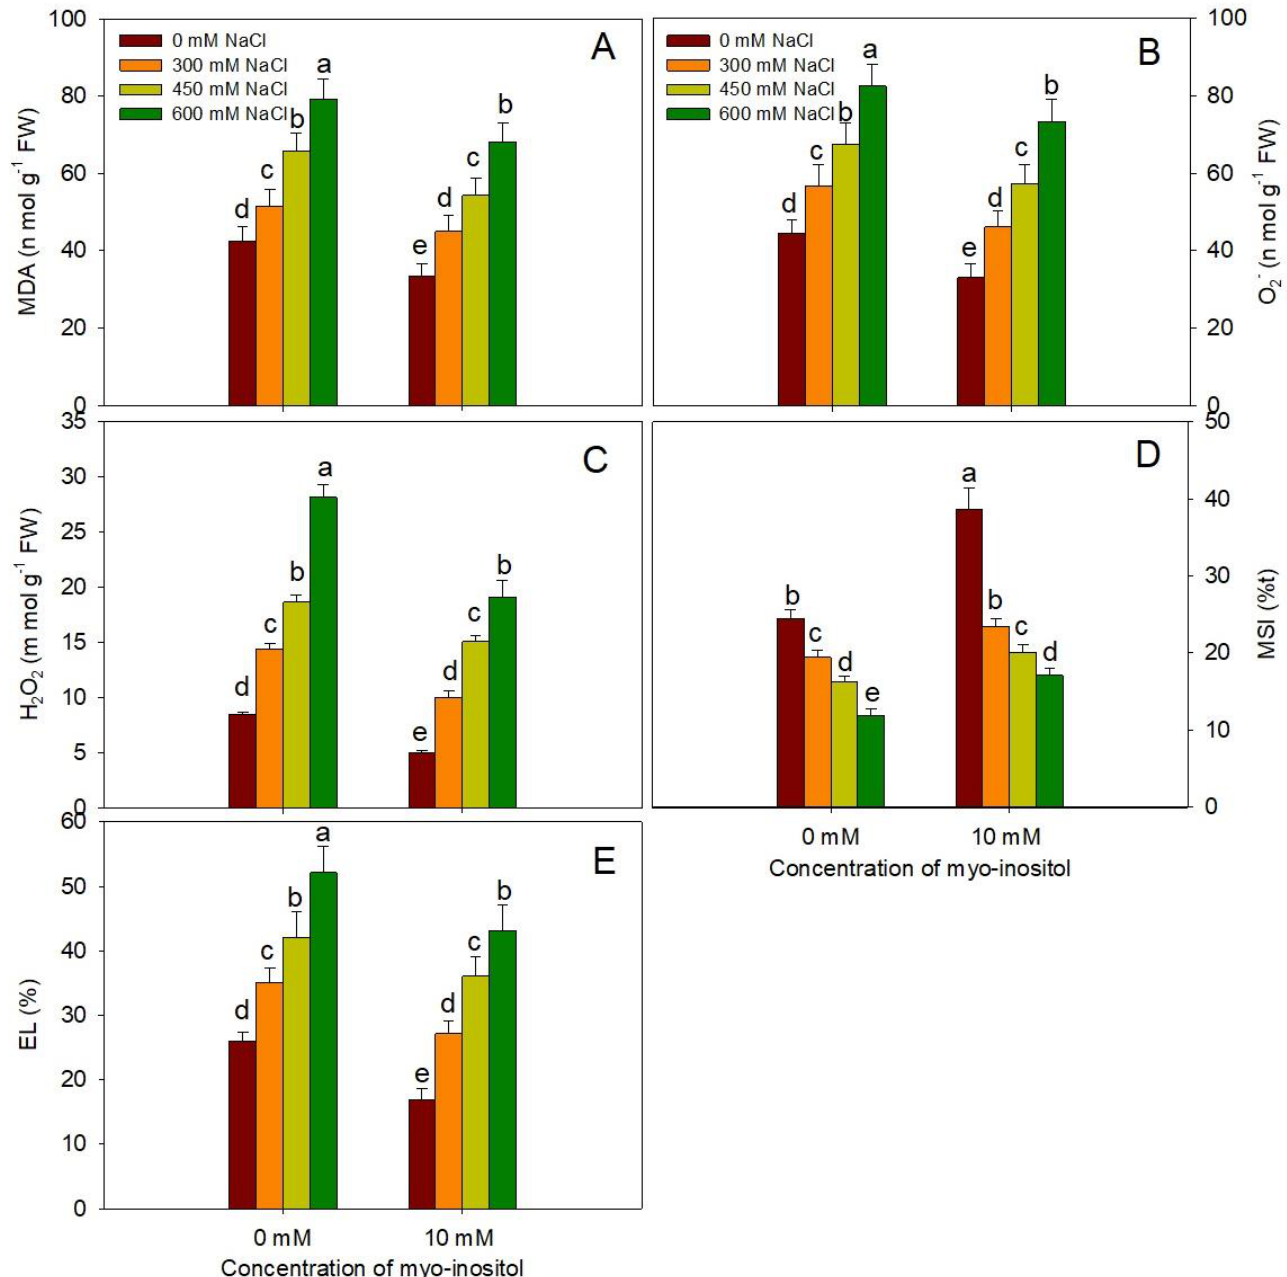
Figure 3. Effect of different salinity (300, 450, and 600 mM NaCl) concentrations with and without exogenous application of myo-inositol (10 mM) on changes in oxidative damage attributes in Quinoa ( Chenopodium quinoa L. var. Giza1). Data expressed as ( A ) malondialdehyde content (MDA); ( B ) superoxide ion (O 2 − ); ( C ) hydrogen peroxide (H 2 O 2 ); ( D ) membrane stability index (MSI), and ( E ) electrolyte leakage (EL). Values are mean (±SE) of four replicates, and different letters represent significant differences at p ≤ 0.05.